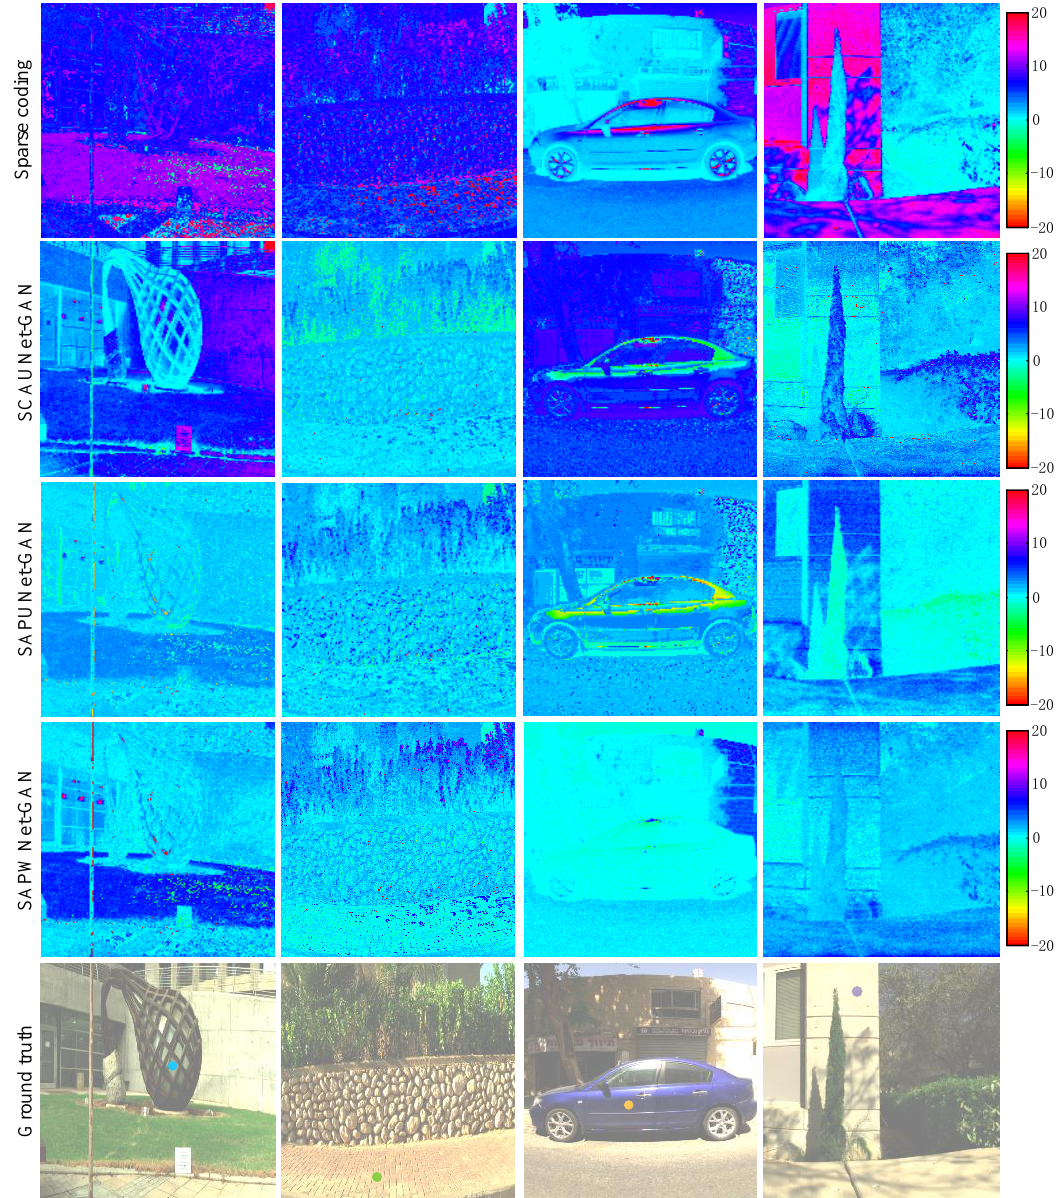
Figure 6. Visual comparison of the hyperspectral recovery of four selected images at 570 nm from the ICVL dataset [3]. From top to bottom: sparse coding [3], SCAUNet-GAN [30], SAPUNet-GAN, SAPWNet-GAN, and